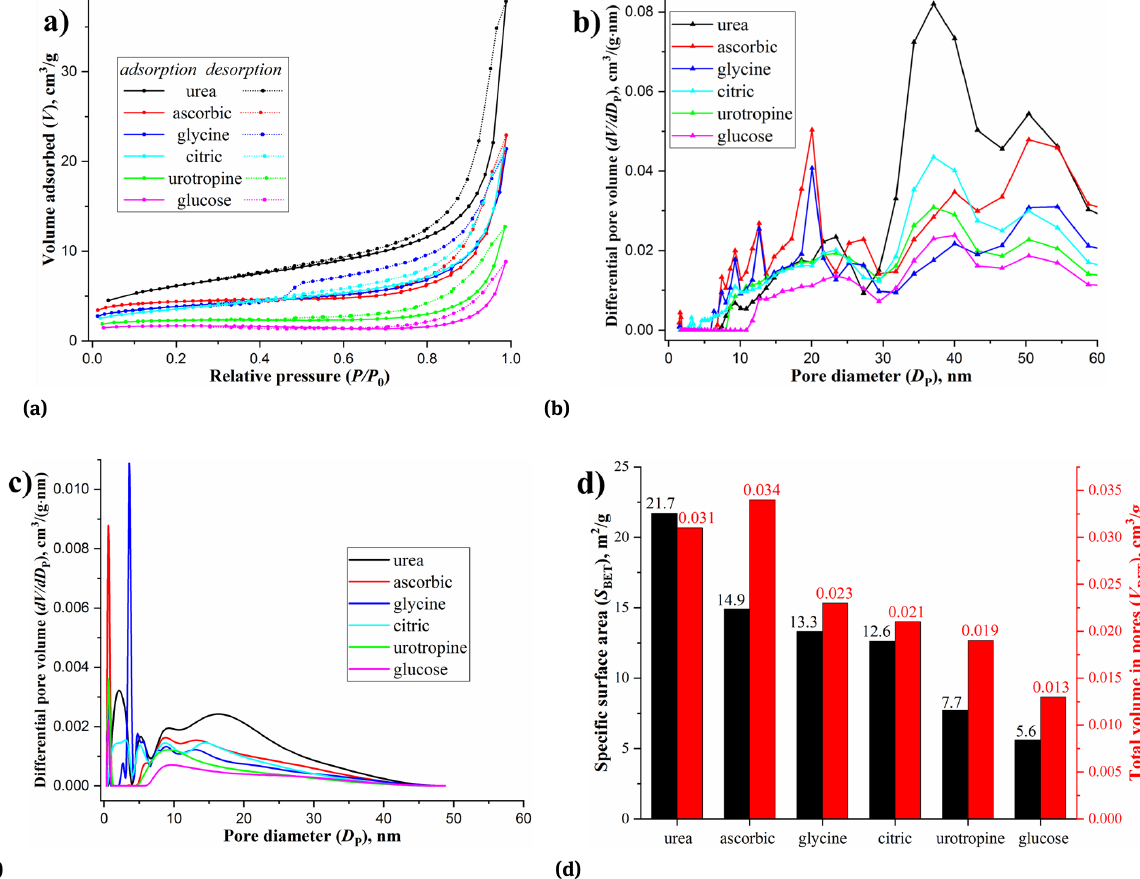
Figure 6: Results of N 2 adsorption-desorption isotherms (a); DFT pore size distribution curves (b); BJH pore size distribution curves (c); specific surface area and total volumes in pores of the synthesized samples.